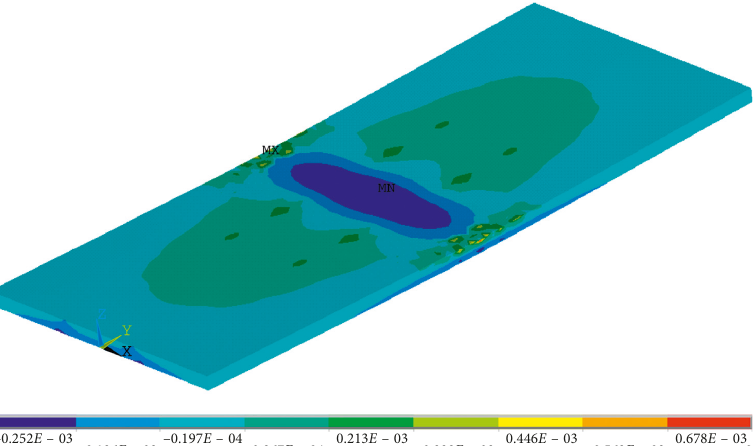
Figure 19: Strain in the concrete